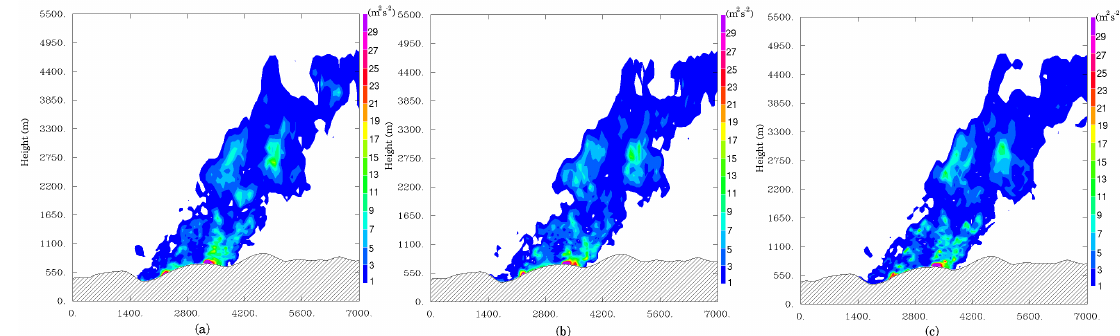
Figure 14. “Coupled” simulation on 23 July 2009 at 1500 UTC: vertical cross-sections along the direction of propagation (axis in Figure 8a) of ( a ) zonal wind variance u (cid:48) 2 , ( b ) meridional wind variance v (cid:48) 2 and ( c ) vertical wind variance w (cid:48) 2 (in m 2 s − 2 ).